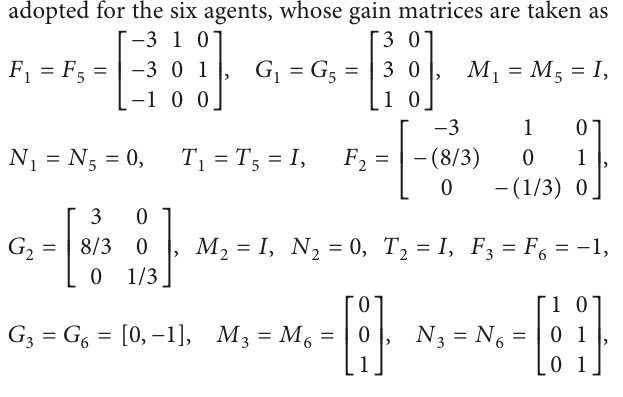
i, 2 via protocol